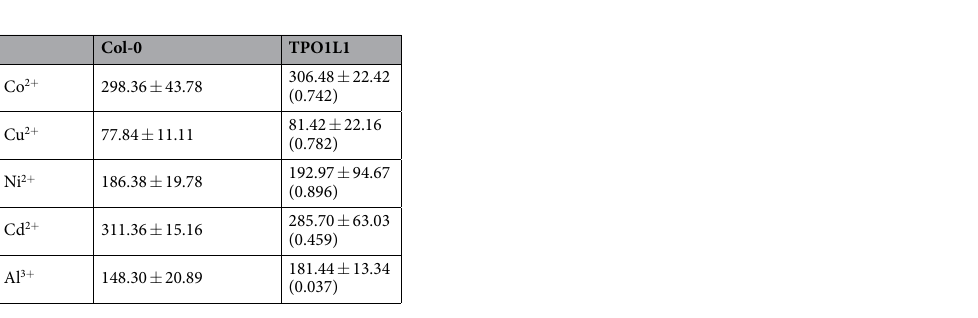
Table 2. Elemental analysis of a transgenic Arabidopsis line expressing the yeast Tpo1p transporter. Total cation concentration ( µ g g − 1 DW) of wild-type and transgenic ScTPO1 -expressing Arabidopsis plants challenged parentheses indicate the P value (comparison with the wild type) obtained by Student’s t